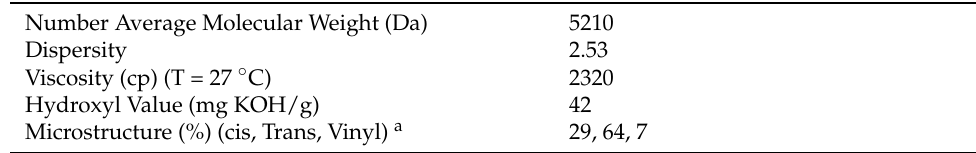
Table 1. Fundamental properties of HTPB binder [16].